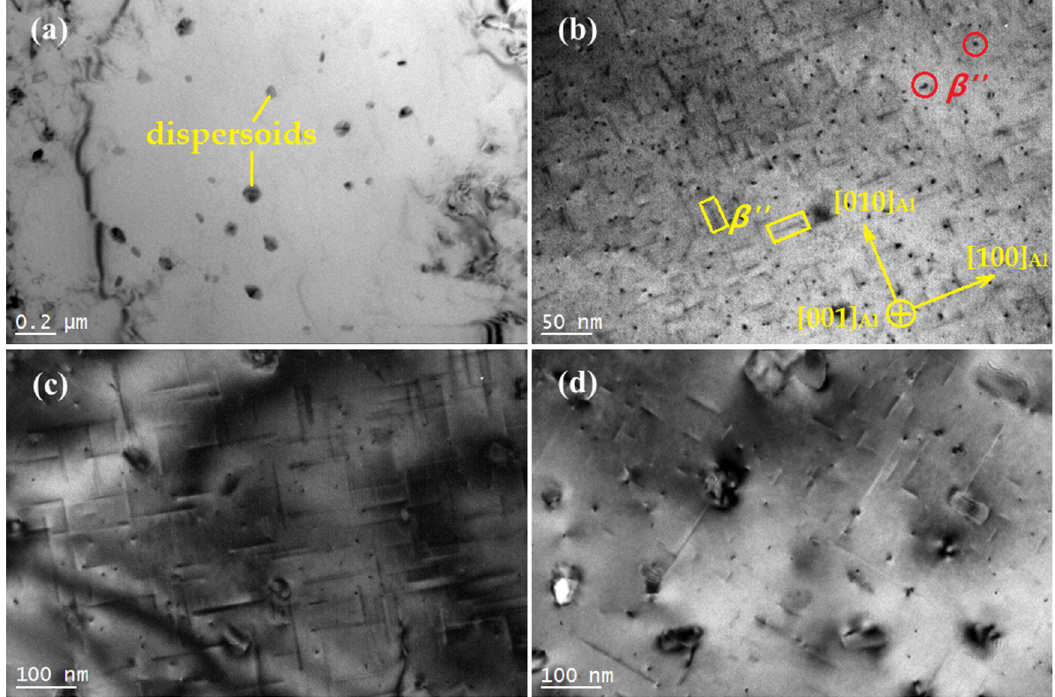
Figure 2. TEM image of the solution-treated and aged alloy, [ 001 ] Al ( a ) as solution-treated; ( b ) aged for 2 h; ( c ) aged for 9 h; ( d ) aged for 12 h.